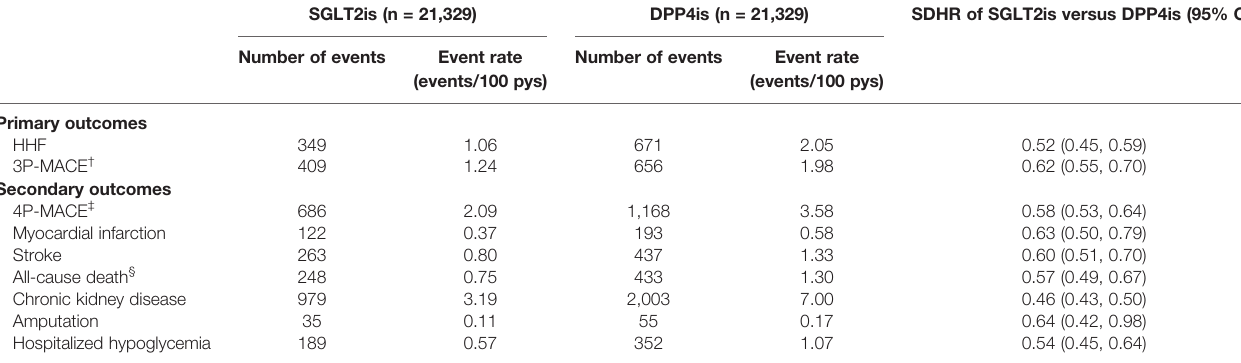
TABLE 2 | Event rates and hazard ratios of clinical outcomes associated with use of SGLT2is versus DPP4is (intention-to-treat